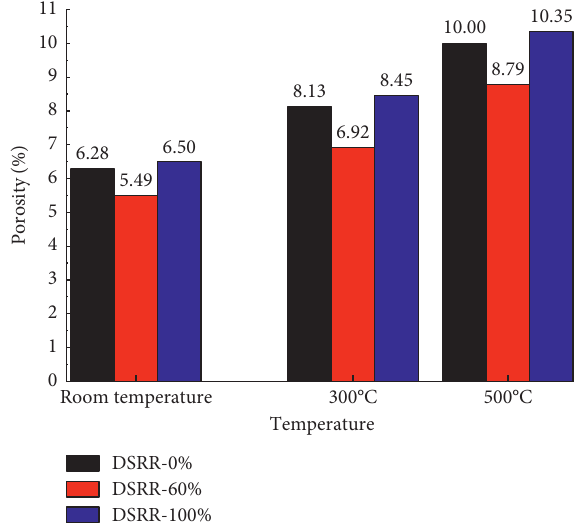
Figure 25: Porosity of DSC after various